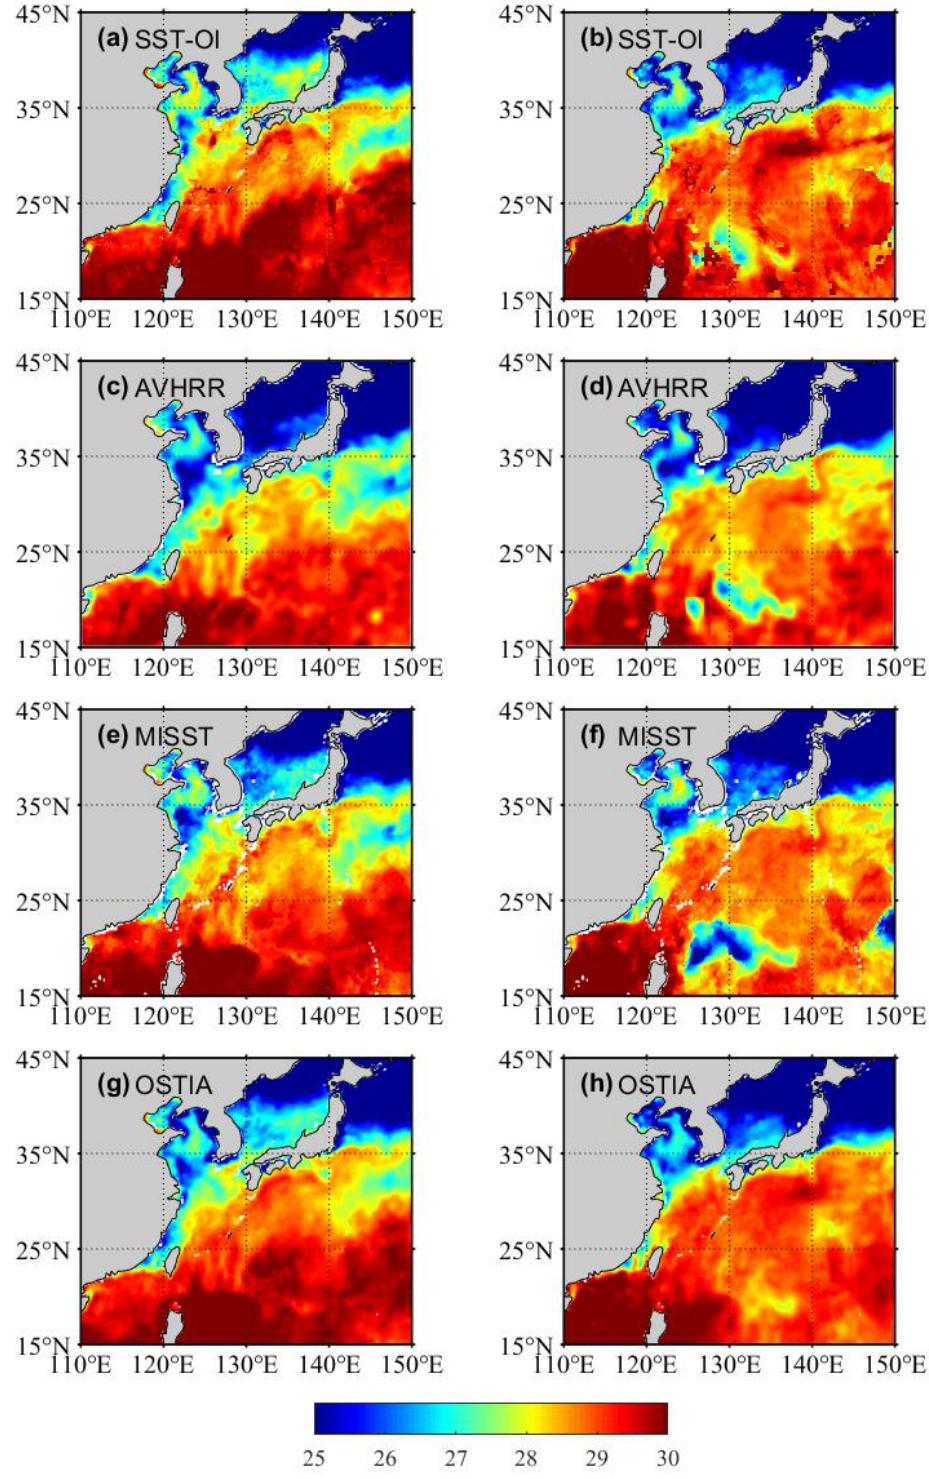
Figure 6. SST distribution of 4 different products in two situations (SST, colored shading; ◦ C). ( a ) SST-OI product on the 15 August 2015 without typhoon impact, and ( b ) SST-OI product on the 20 August 2015 affected by typhoon. ( c , d ), ( e , f ) and ( g , h ) as in ( a , b ), but for AVRHH, MISST, OSTIA product